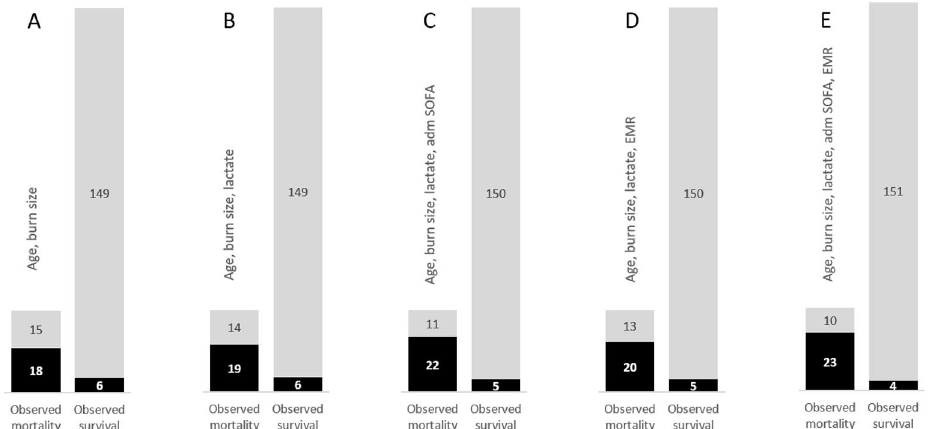
Figure 4. Observed and predicted mortality by five models. Observed mortality was 33 patients and observed survival was 155 (calculated on the 188 patients who had blood lactate taken at admission). The first two bars on the left side ( A ) show that the variables age and burn size, predicted 18 true positive and 149 true negative. ( B ) The model with age, burn size, and lactate, predicted 19 true positive. ( C ) That with age, burn size, lactate, and admission SOFA, predicted 22 true positive and 150 true negative. ( D ) The model with EMR instead of SOFA, predicted 20 true positive. ( E ) The combination of the previous variables resulted in 23 true positive and 151 true negative. Predicted mortality = black. Predicted survival =